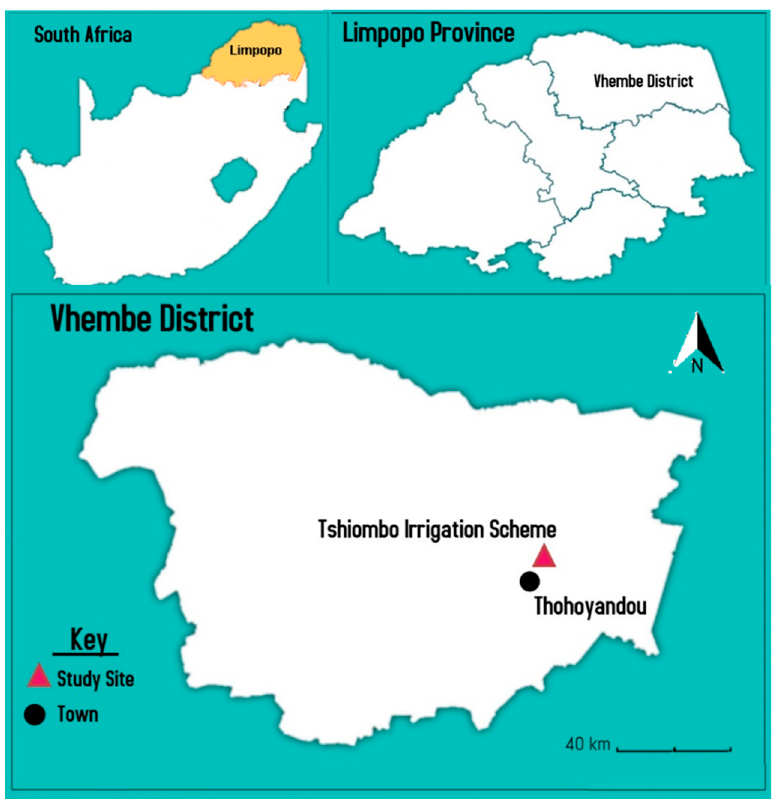
Figure 1. Study site, Limpopo province (Source: Author).